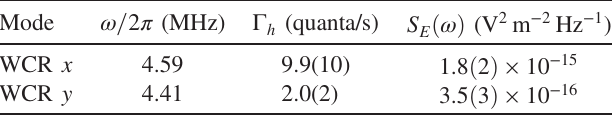
TABLE I. Properties of the WCR modes of the two-ion crystal: frequency ω = 2 π , heating rate Γ h , and calculated electric-field noise power spectral density at this frequency S E ð ω Þ .